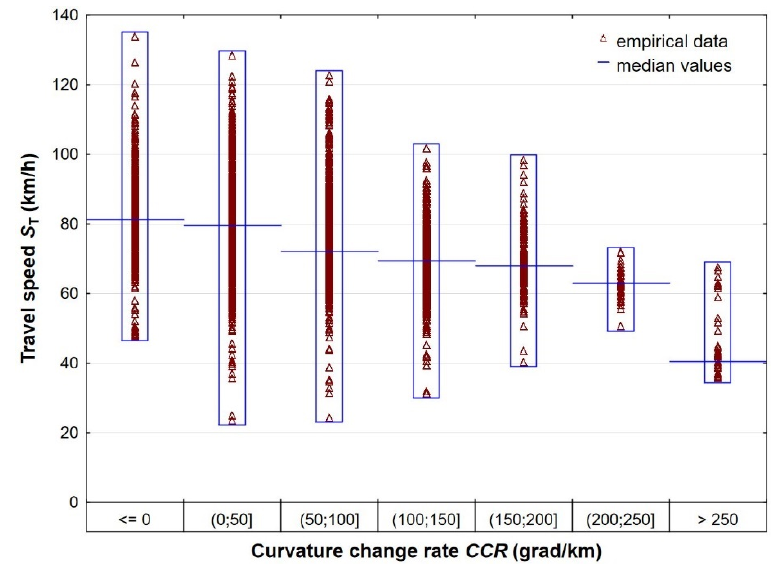
Figure 5. Interaction of travel speed and a road’s curvature change rate CCR.